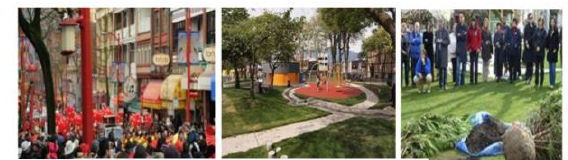
Figure 6. Oppenheimer